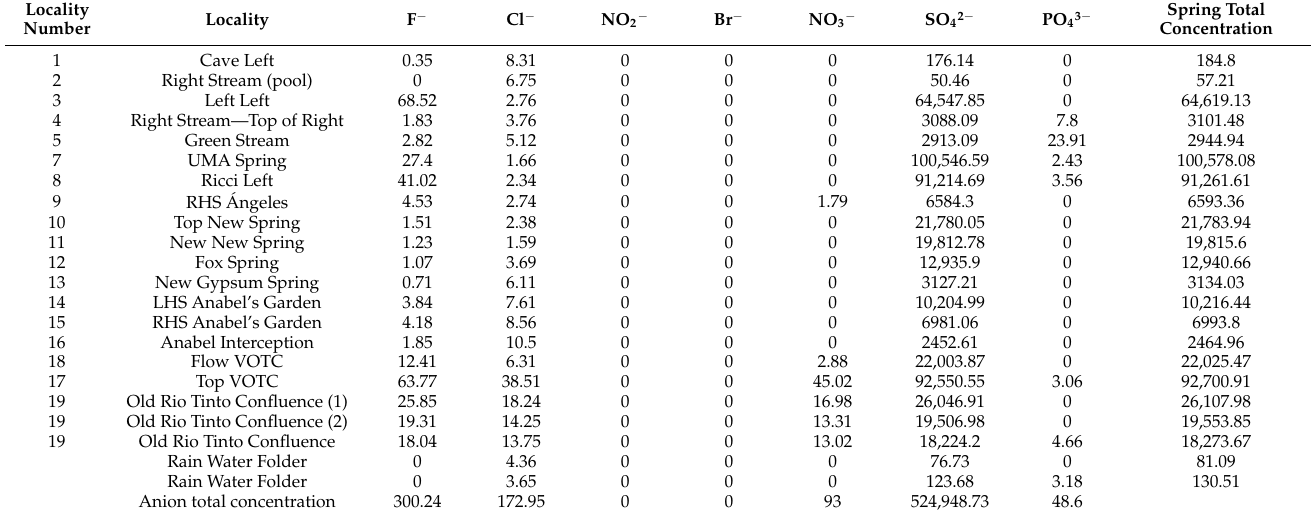
Table 5. Anion water composition (mg · L − 1 ) obtained through ion chromatography of the sample solutions. Locality